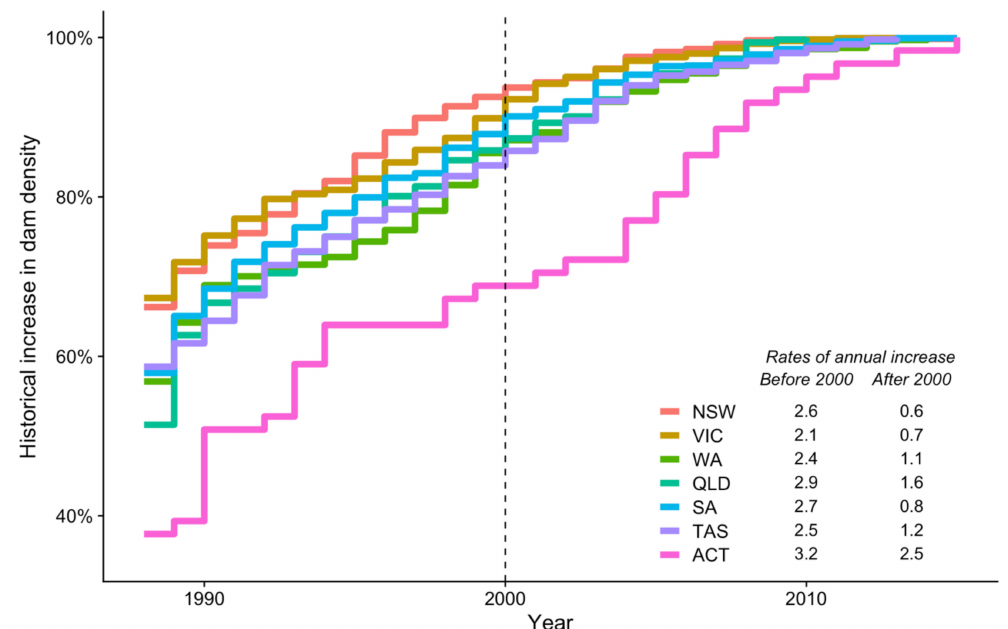
Figure 6. Historical trends in dam density between the years 1988 and 2015 in each State and Territory of Australia. The embedded table shows annual rates of proportional increases in dam densities, both before 2000 and after 2000 (dashed line). There were too few data to calculate historical rates for dams in the Northern Territory. See Figure S6 for absolute and relative rates of annual increase for each region and Figure S7 for trends in farm dam size over time.